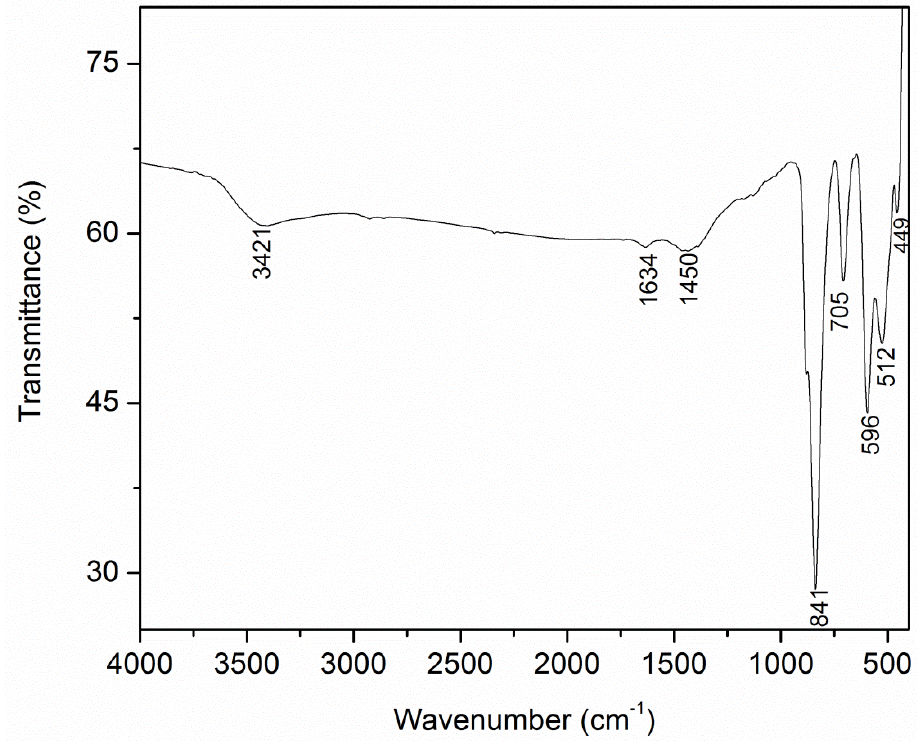
Figure 1. FT-IR spectrum of Cu-ZnBO-Cp-CT.